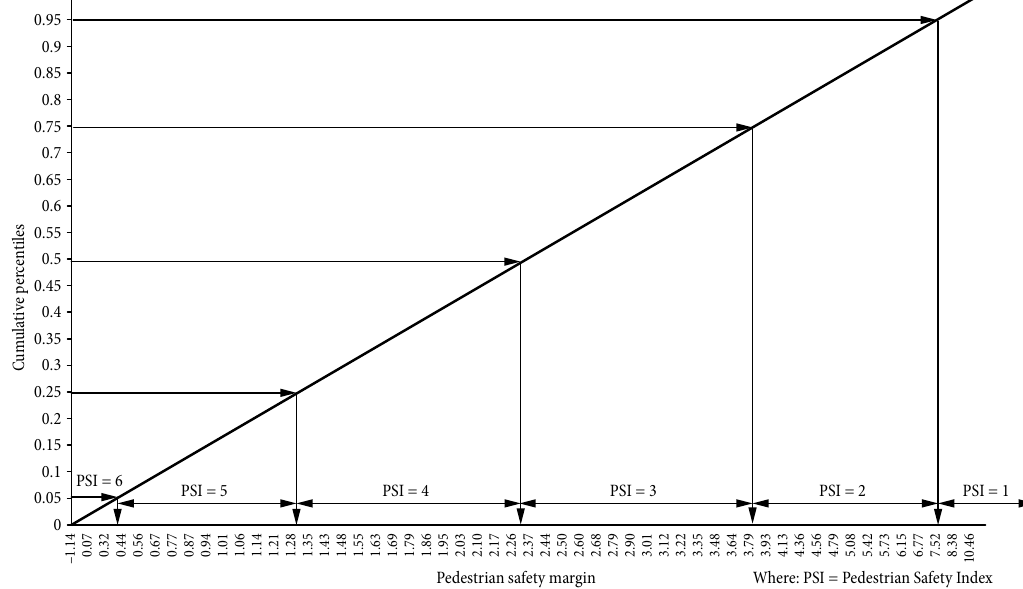
Fig. 2. Distribution of pedestrian safety margin used for PSI